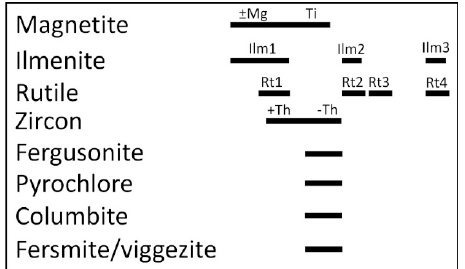
Figure 4. Crystallization succession scheme of HFSE-rich minerals and Fe–Ti oxides.